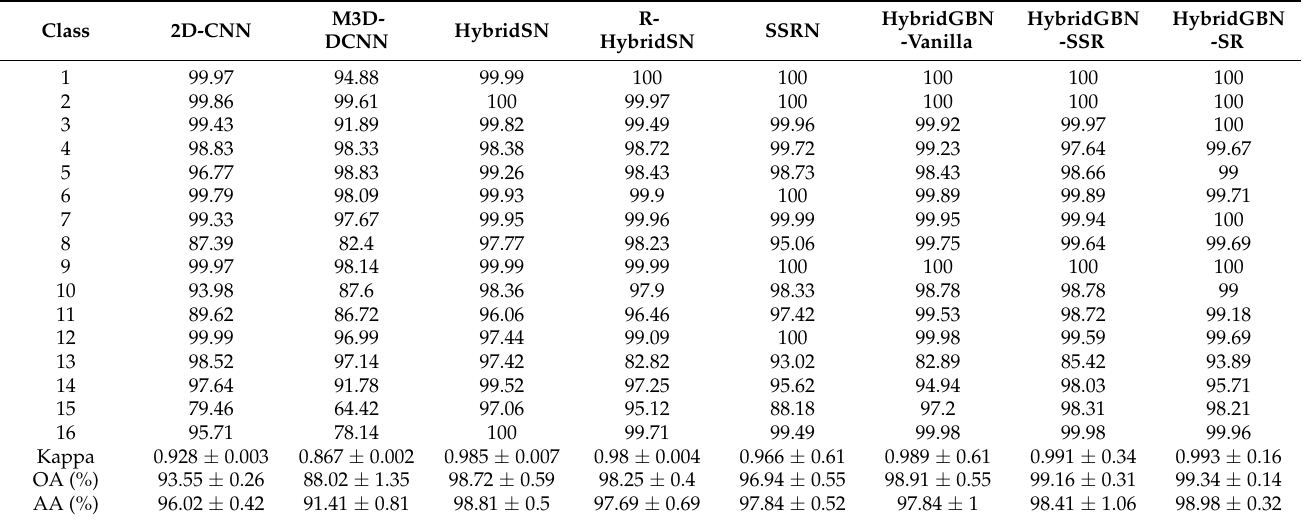
Table 6. The Kappa, OA, and AA results in a percentage of the compared models at 1% training sample data over the SA